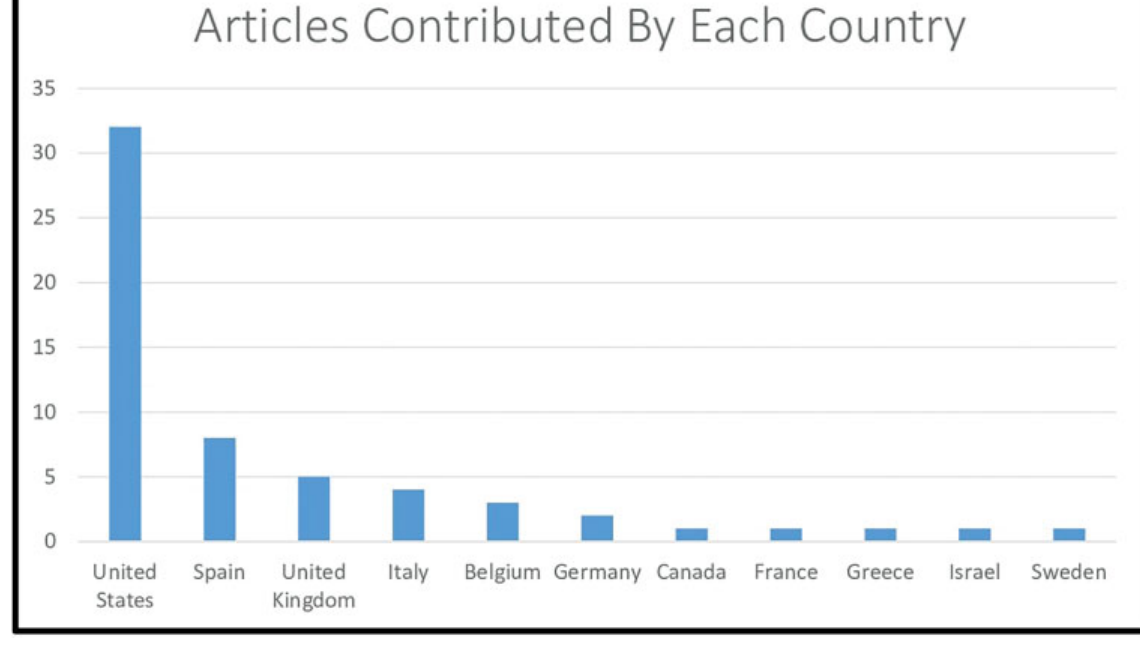
Fig. 1 Distribution of articles by country of